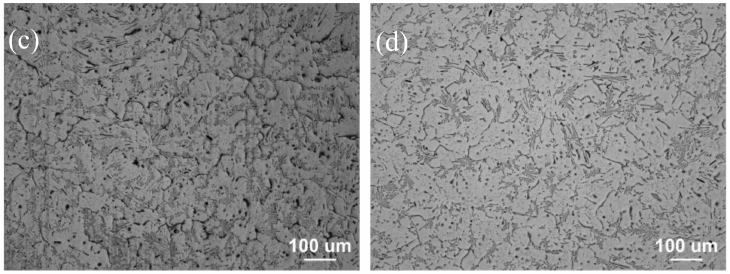
Figure 2. OM images of as-cast alloys: ( a ) TX31; ( b ) TXZ311; ( c ) TXC311; ( d )